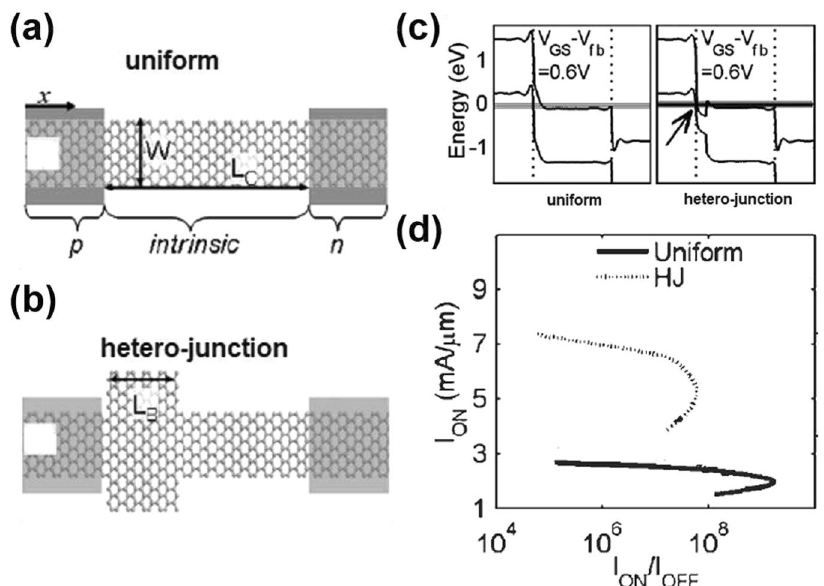
Fig. 9 Simulation Report of Nanoscale 2D GrNR-TFET. Schematics of a uniform and b hetero-structure GrNR-TFET and subsequent c lateral band-pro fi les at on-state, d drive current as a function of on-state/off-state current ratio, adapted with permission from 80 . Copyright (2010) IEEE.